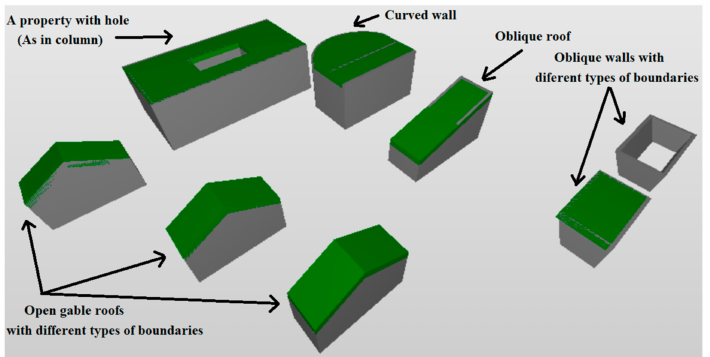
Figure 20. The test dataset with oblique and curved structures and